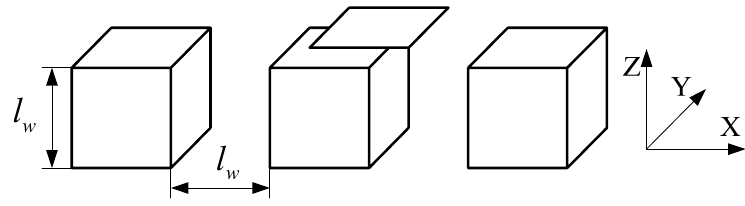
Figure 6. Simplified model of the coil-stator